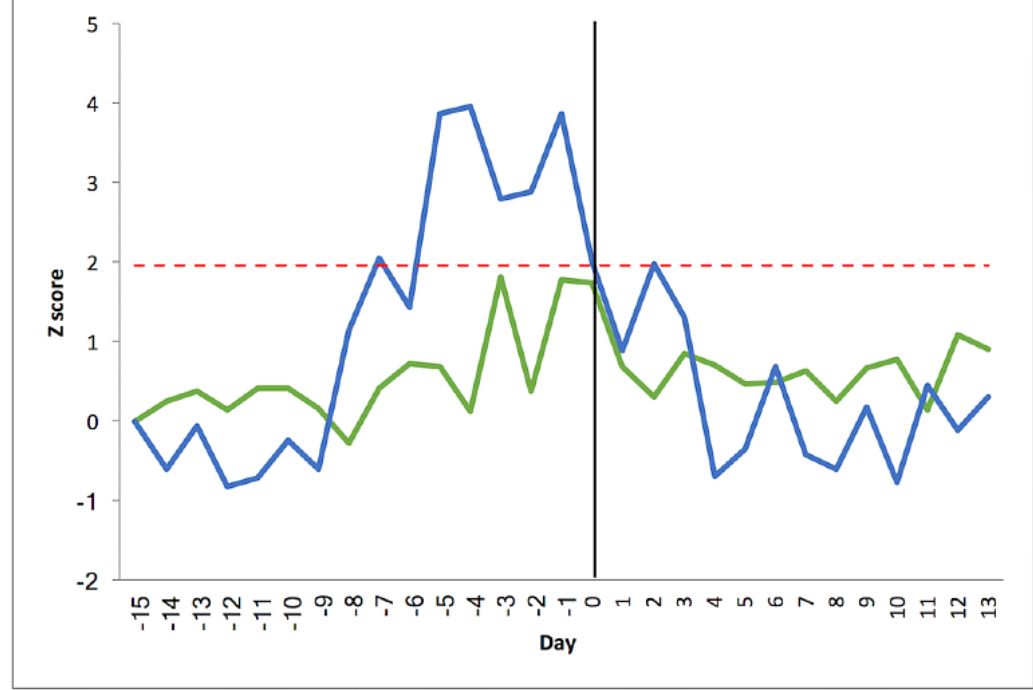
Figure 3. Heart rate changes pre and post exacerbation for the 27 patients with chronic obstructive pulmonary disease. The y-axis represents the Z score relative to the patient’s baseline mean. The x-axis represents the time expressed in days. Day −15 is the mean of the stable period, days −14 to −1 is the preexacerbation period, day 0 is the day of initiation of treatment for exacerbation, and days 1 to 13 is the postexacerbation recovery. The red line represents the threshold limit of +1.96 SD. The once-daily group is represented by the green line and the overnight group by the blue